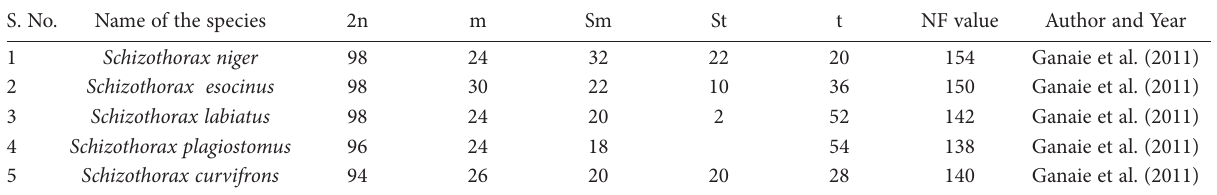
Table 2. Chromosome classification of various Schizothorax species, worked out in Kashmir valley (m = metacentric; Sm = sub-metacen- tric; St = sub-telocentric; t = telocentric; NF = fundamental arm number). S. No.